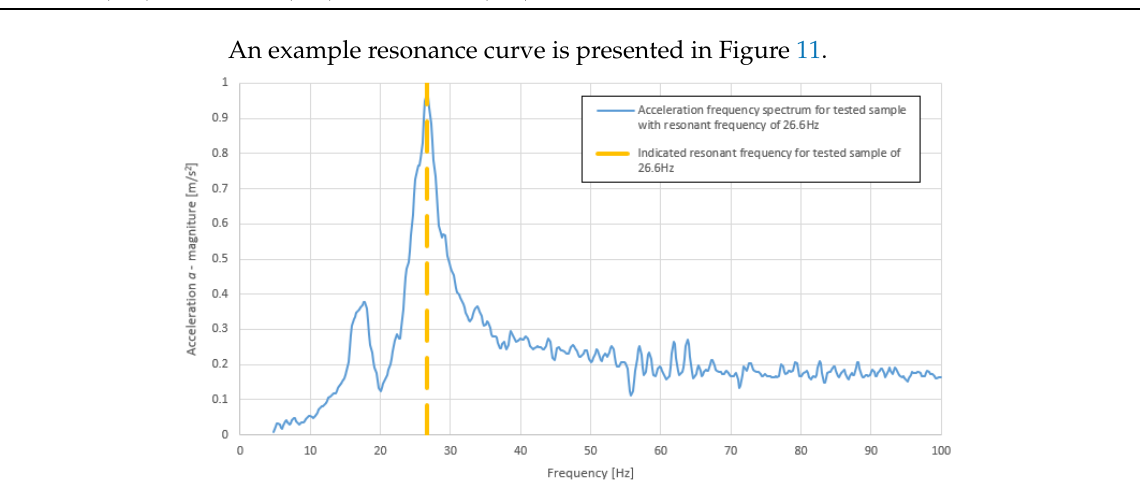
Figure 11. Acceleration frequency response spectrum of an example sample of Ursa TEP 23 mm mineral wool with indication of resonant frequency (own elaboration).